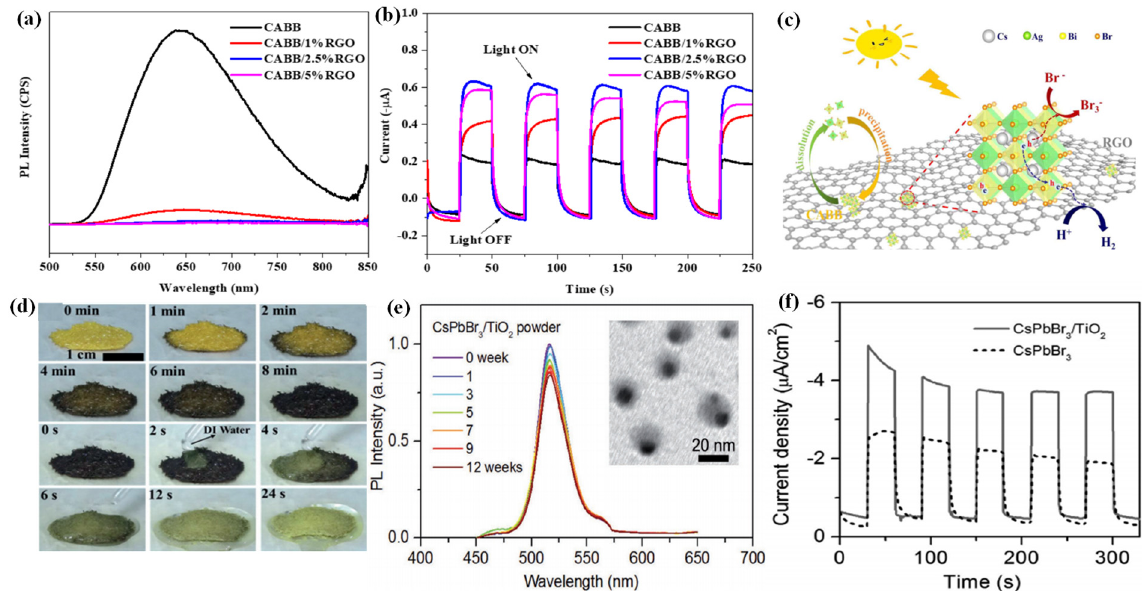
Figure 6. ( a ) Steady-state PL spectra of the CABB/xRGO composites (x = 0, 1%, 2.5%, 5%). ( b ) Pho- tocurrent responses of the CABB/xRGO samples (x = 0, 1%, 2.5%, 5%) recorded at 0 V vs. Ag/AgCl electrode. ( c ) Schematic mechanism of photocatalytic HBr splitting by CABB/RGO under visible light irradiation. ( d ) In situ observation of the reversible DMASnI 3 transformation process at 80 °C in air. ( e ) The relative PL intensity of CsPbBr 3 /TiO 2 NCs after immersing in Milli-Q water (0–12 weeks). Inset: TEM image of CsPbBr 3 /TiO 2 NCs after immersing in Millil-Q water for 12 weeks. ( f ) Transient photocurrent responses of CsPbBr 3 and CsPbBr 3 /TiO 2 NCs electrodes at − 0.1 V versus NHE. ( a – c )